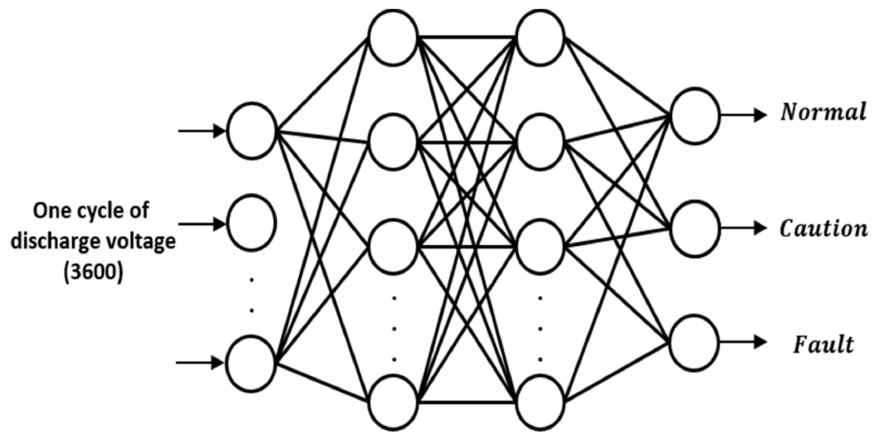
Figure 9. MNN structure for the SOH diagnostic